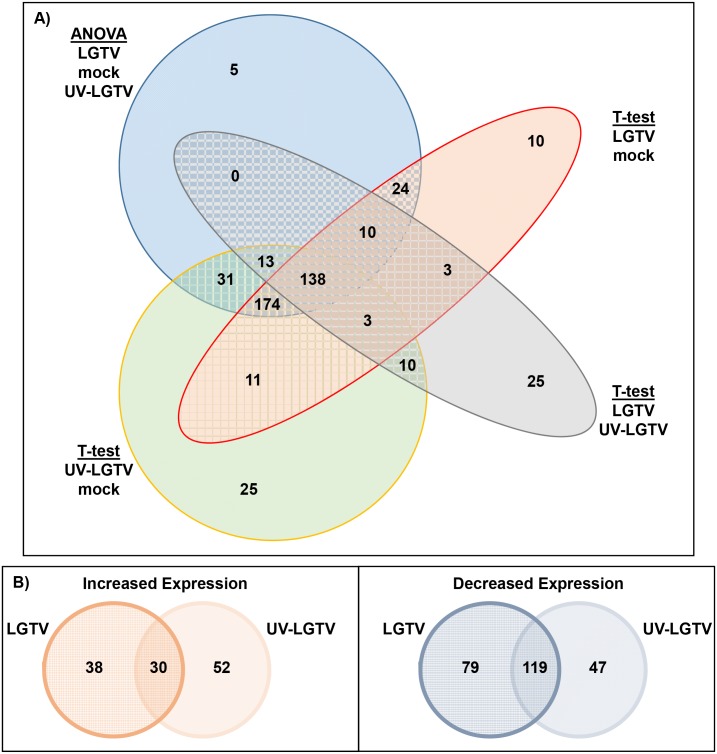
Identification and expression of ISE6 cell proteins following treatment to LGTV, UV-LGTV, and mock.(A) Four statistical analyses were performed using the ODP output. This included a three-way ANOVA of treatment groups LGTV, UV-LGTV, mock and two-way t-test comparing the LGTV vs. mock, UV-LGTV vs. mock, and LGTV vs. UV-LGTV samples. The Venn diagram shows unique and common ISE6 protein identifications from these datasets. (B) Venn diagrams showing the numbers of ISE6 proteins identified as exhibiting increased or decreased expression following treatment to LGTV or UV-LGTV unique or common to sample groups (see S2 and S5 Tables for the complete list of proteins identified in the analyses).